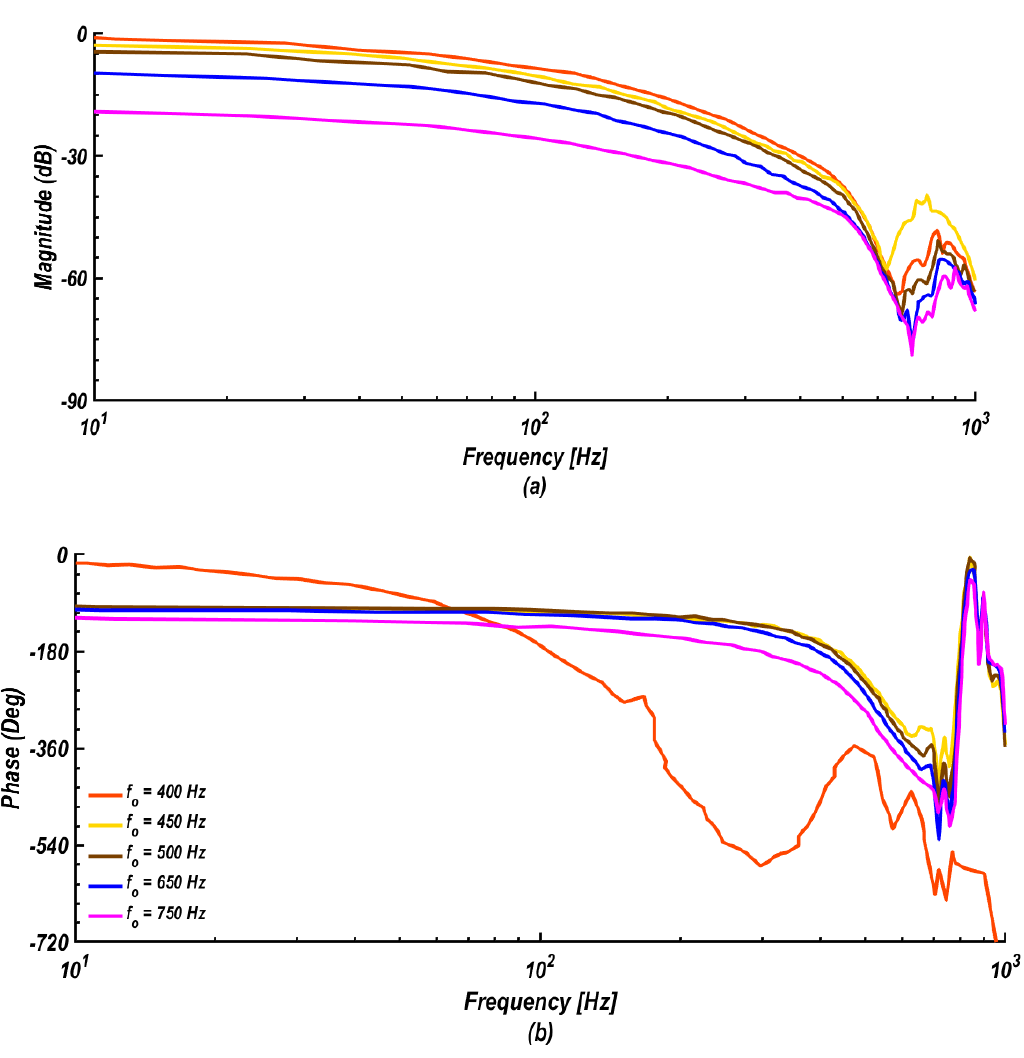
Figure 18. A set of frequency responses of the open-loop transfer function of the controller-plant system, GpGc . ( a ) Magnitude in decibel versus frequency in Hz. ( b ) Phase in deg versus frequency in Hz.